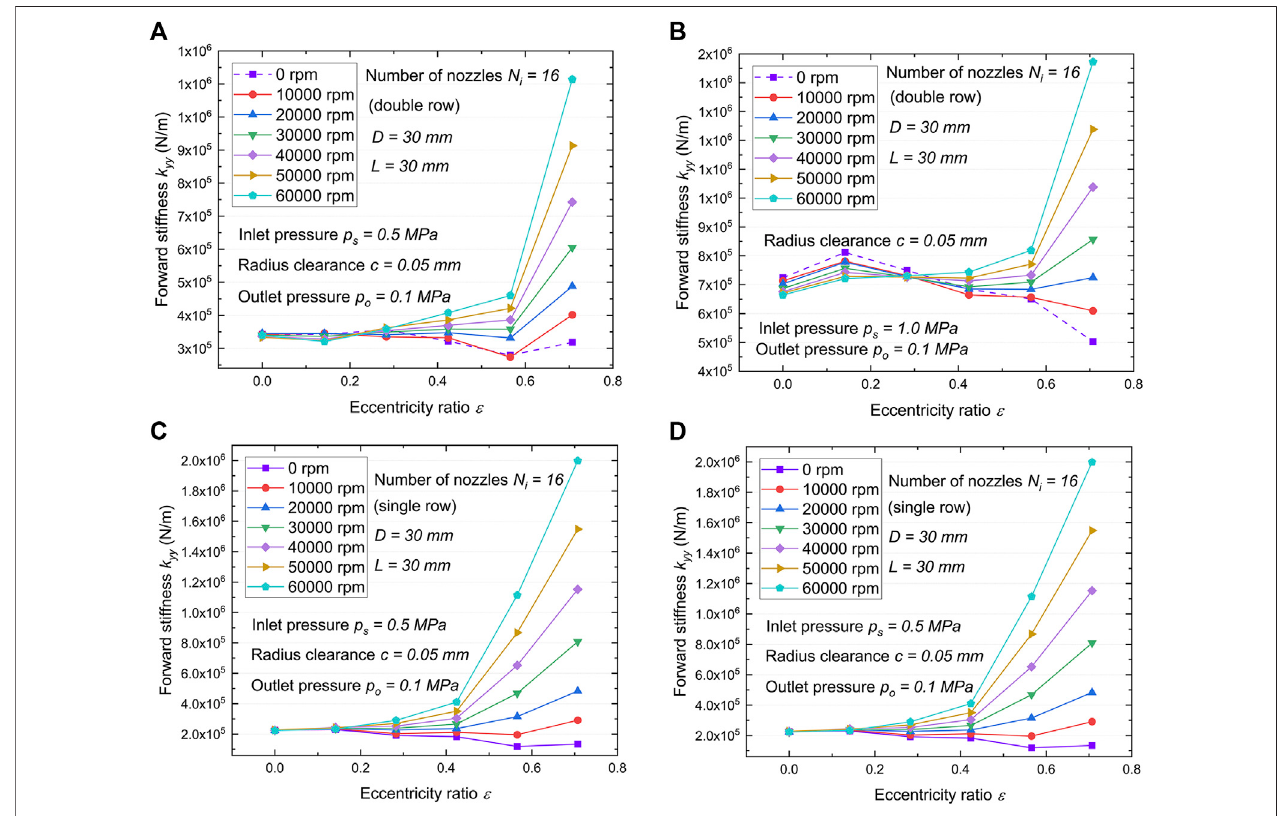
FIGURE9| Variationsofforwardstiffnesscoef fi cient k yy witheccentricityratioversusrotorspeed. (A) Doublerow, p s =0.5 MPa. (B) Doublerow, p s =1.0 MPa. (C) Single row, p s =0.5 MPa. (D) Single row, p s =1.0 MPa.